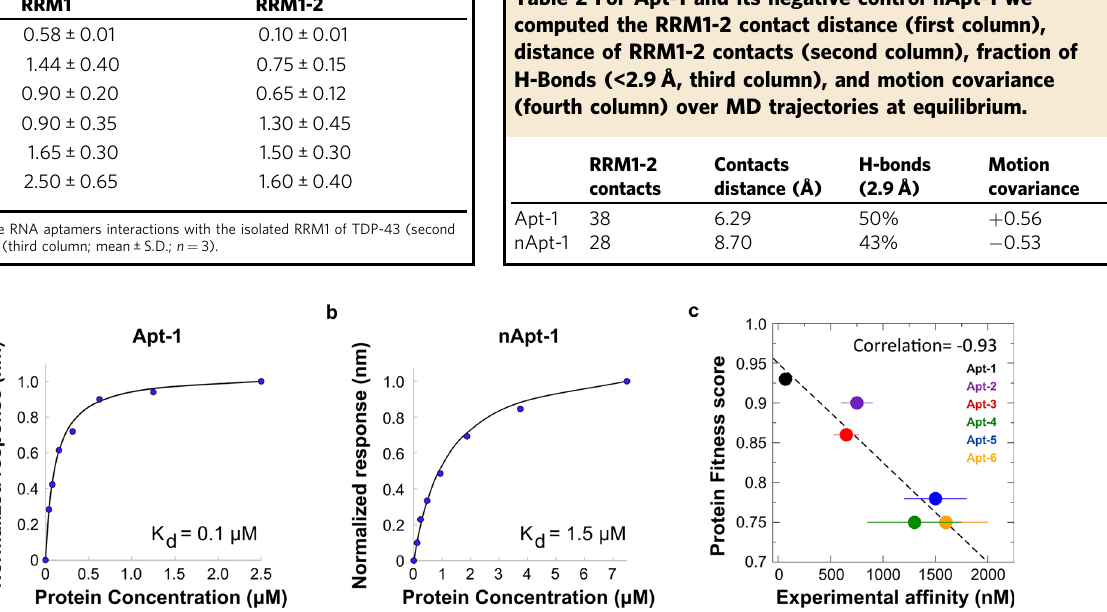
Fig. 2 In vitro validation of aptamers binding af fi nity. a Binding response curve for the interaction between RRM1-2 and Apt-1. b Binding response curve for the interaction between RRM1-2 and negative RNA (antisense Apt-1). c Experimental K d and Protein Fitness scores are tightly anti-correlated (Pearson correlation of − 0.93). The experimental values are reported in Table 1. Source data are provided as a Source data fi le 64 .